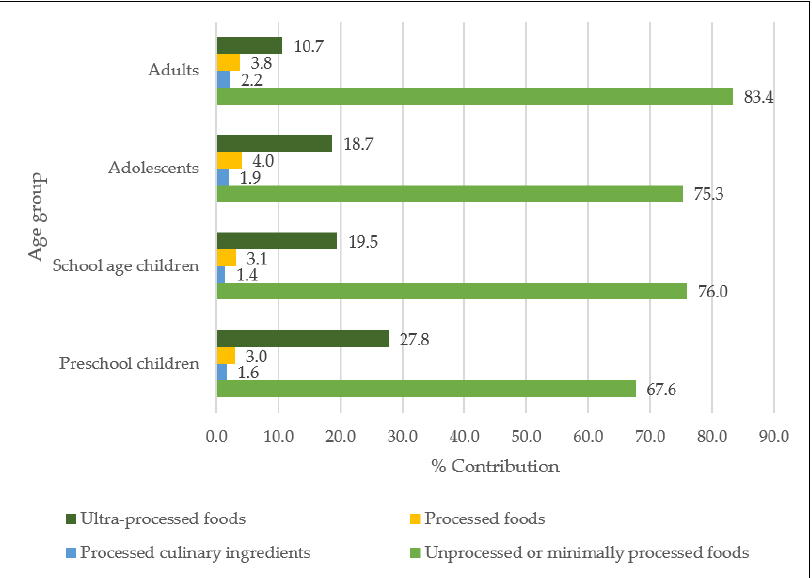
Figure 2. Percentage contribution of potassium intake by Nova classification in the Mexican population: ENSANUT-2016.